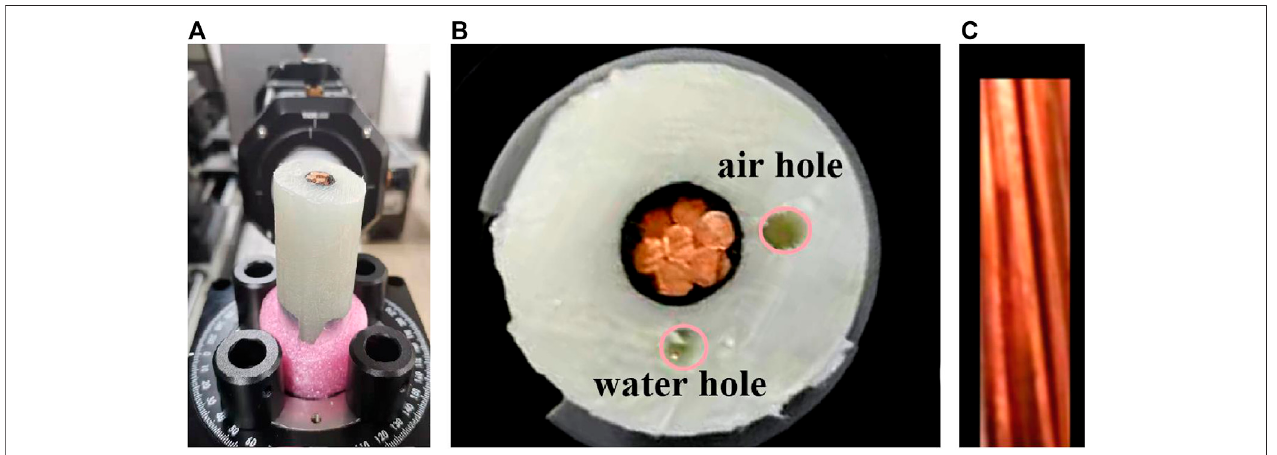
FIGURE 3 | Cable sample. (A) Lateral view; (B) vertical view; (C) structure of the cable conductor